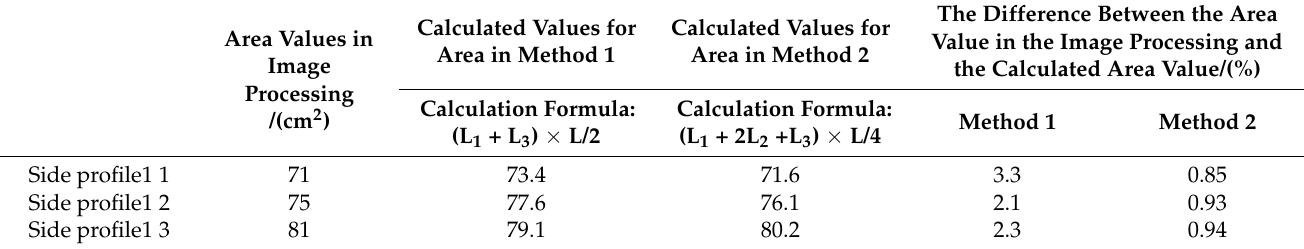
Table 1. Area values of the side